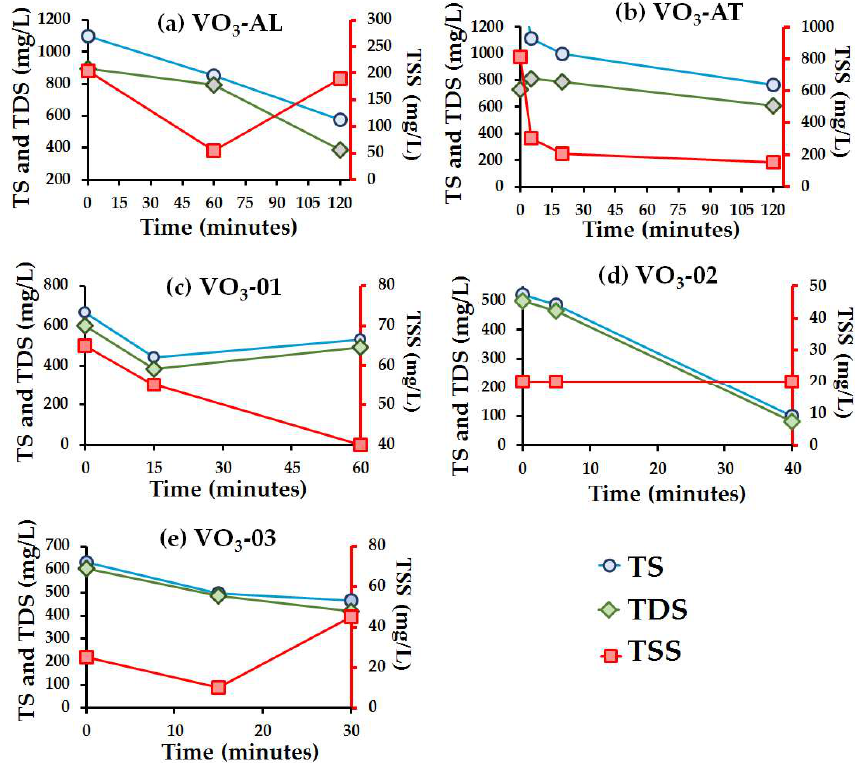
Figure 6. Total, dissolved and suspended solids of collected water at different times of ozone application. ( a ) Sampling point from Alseseca River, ( b ) Sampling point from Atoyac River, ( c ) Sampling from Valsequillo reservoir (inside the water hyacinth coverage), ( d ) Sampling from Valsequillo reservoir (after the water hyacinth coverage), ( e ) Sampling from Valsequillo reservoir (east zone).